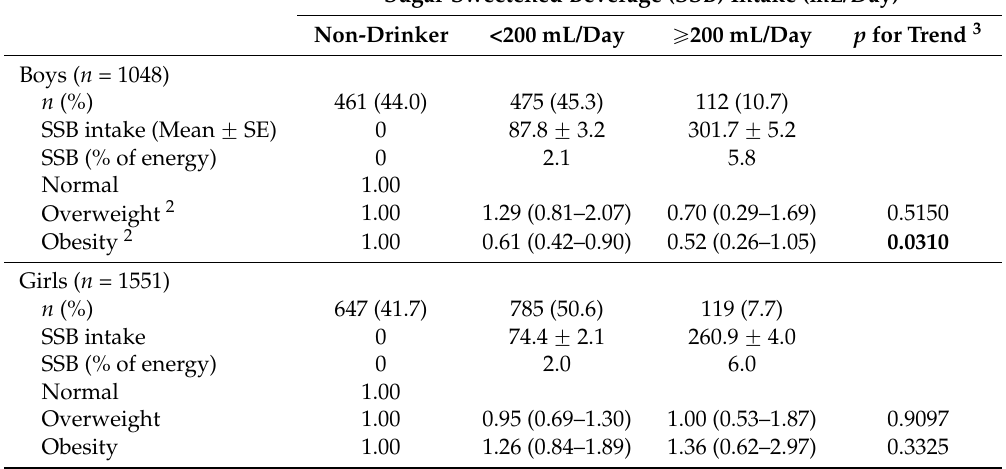
Table 4. Multivariate-adjusted odds ratios (ORs) and 95% confidence intervals (CIs) for pediatric overweight and obesity across sugar-sweetened beverage